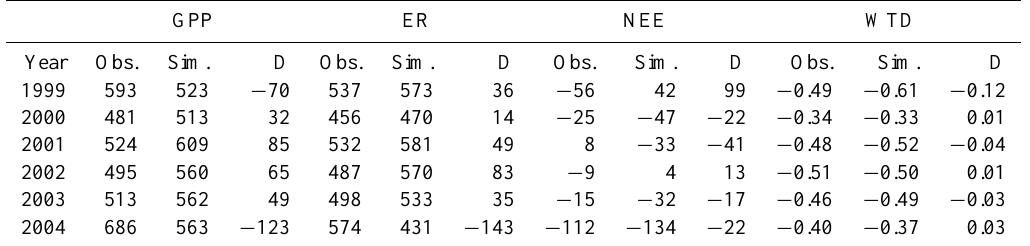
Table 6. Observed (Obs.), simulated (Sim.), and the difference (D) between observed and simulated annual GPP, ER and NEE (units: gCm − 2 yr − 1 ) and summer average water table depth (unit: m) from 1 May to 30 October for 6yr for the Mer Bleue